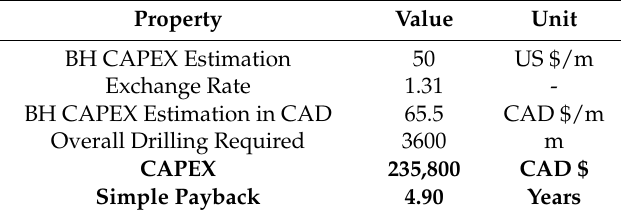
Table 6. Payback period of the proposed